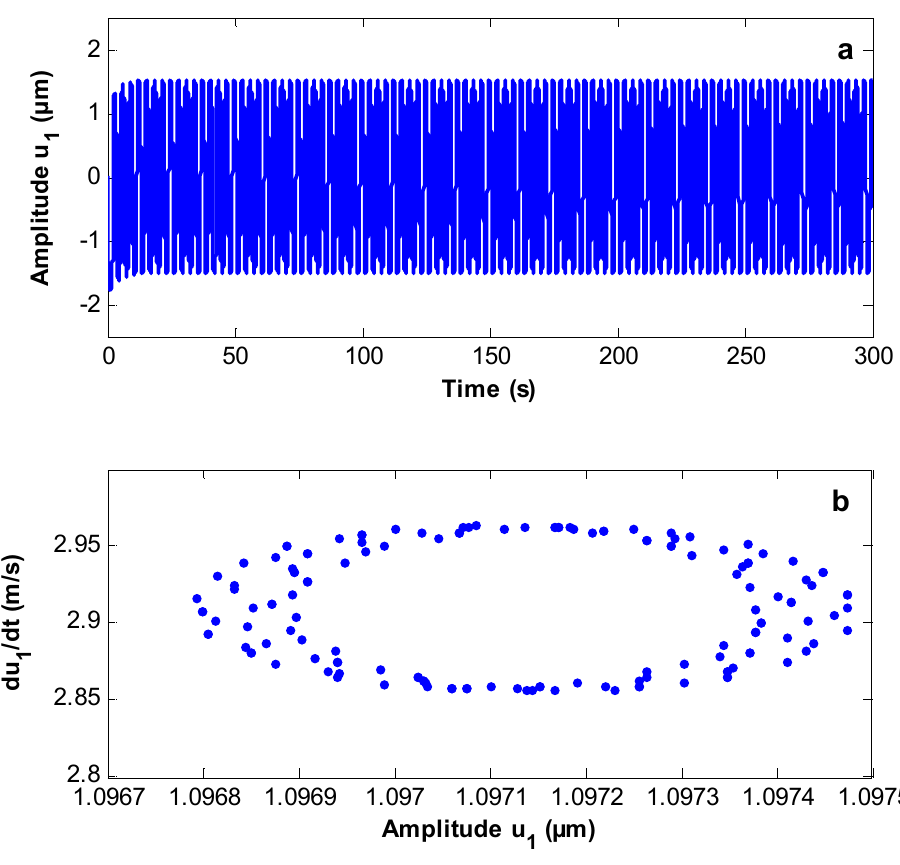
Figure 8. ( a ) Time responses. ( b ) Poincaré map of the controlled system at Ω ≅ 𝜔,Ω (cid:2869) ≅ 2𝜔, 𝛼 (cid:2869) = 28, 𝛼 (cid:2870) = 0.5, and 𝜎 (cid:2869) = 0.25 .